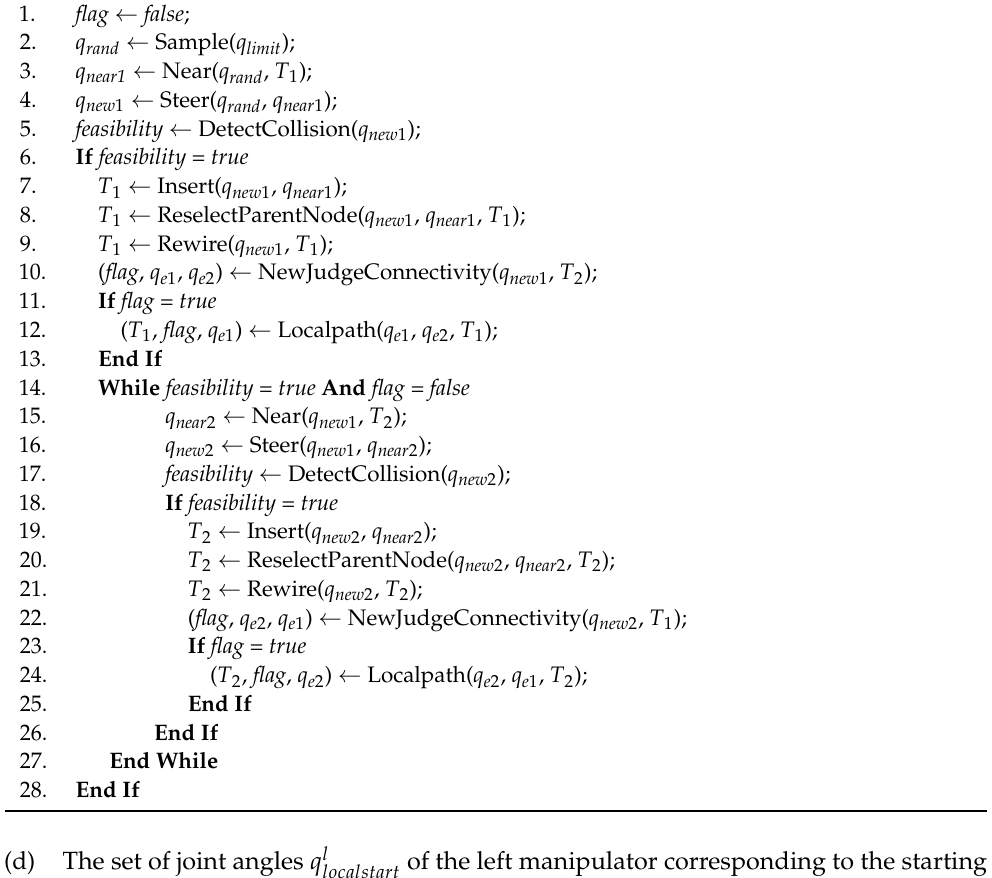
Algorithm 7 ( T 1 , flag , q e1 , q e2 ) ← NewExtend( T 1 , T 2